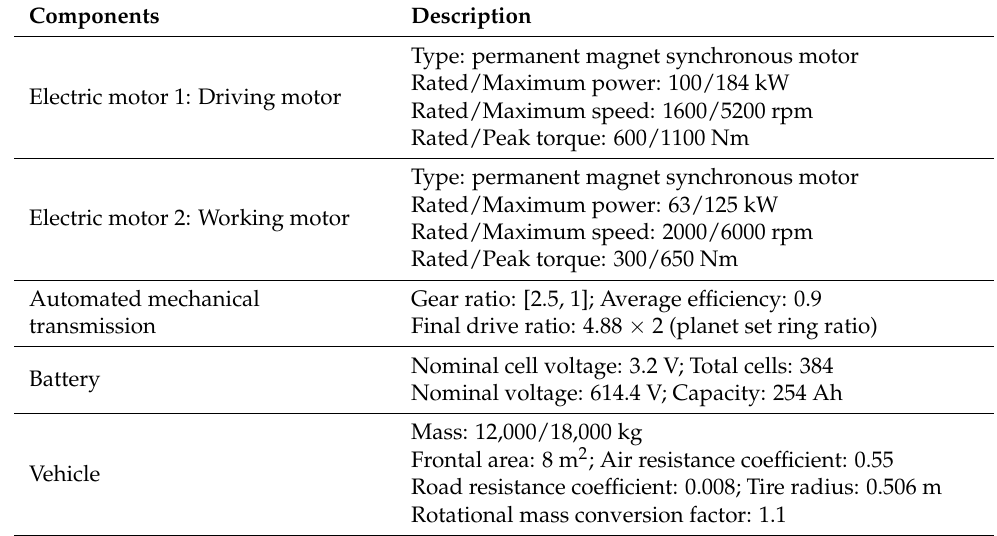
Figure 2. Structure of the electric sanitation vehicle. Table 1. Main parameters of the sanitation vehicle insurance.